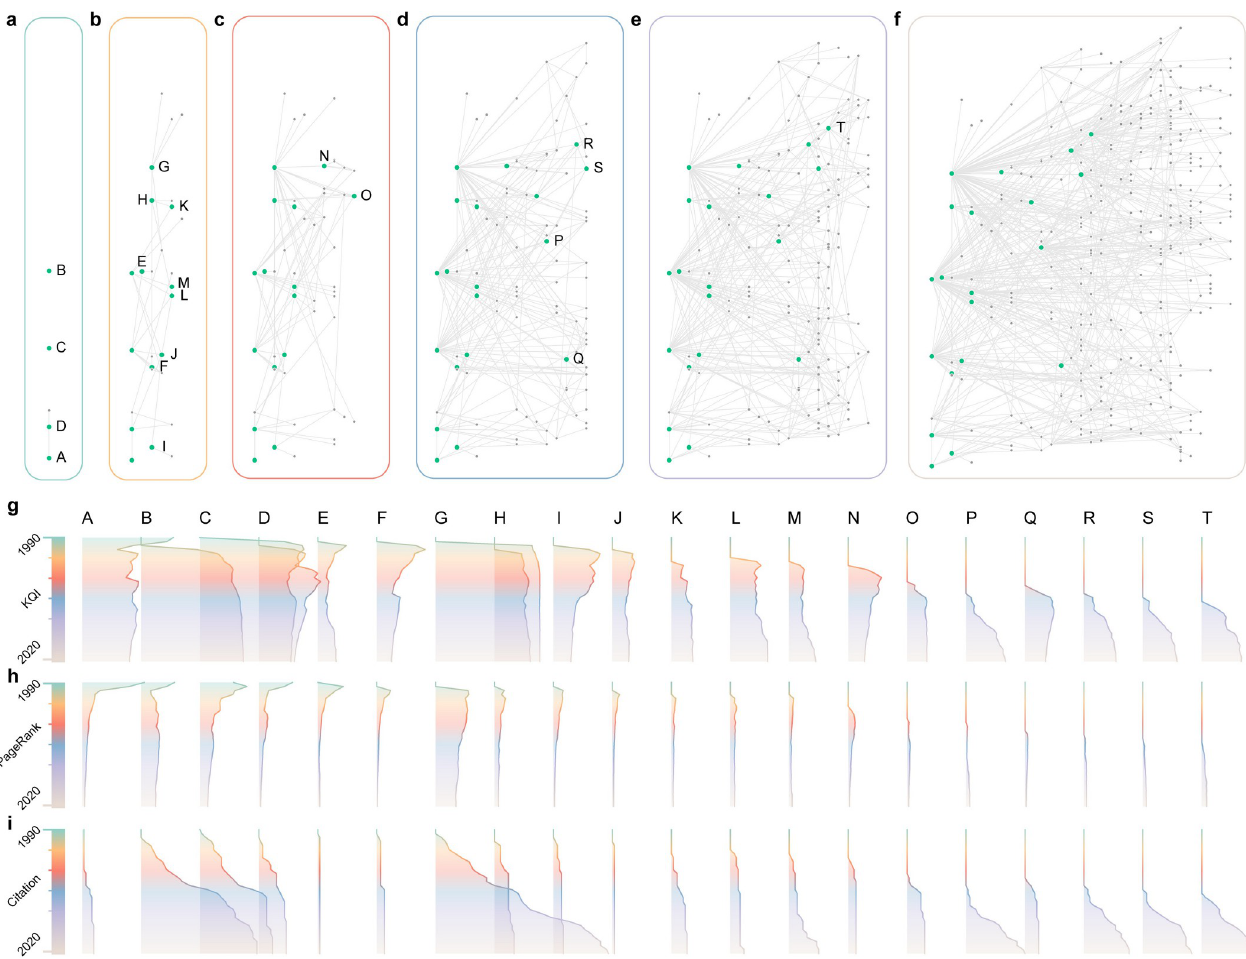
Fig 5. KQI changes with the evolutional network. a-f, Simplified evolutional network on informetrics field from 1990 to 2021. Nodes represent the articles and edges represent the citation relationships. The nodes at the right cite the nodes at the left, in chronological order from left to right. The networks correspond to snapshots in 1990, 1995, 2000, 2005, 2010, and 2020 respectively. Additional 20 nodes (green) are marked to specifically compare with changes in metrics. g-i, KQI, PageRank, and citation variation of typical nodes. The gradient color corresponds to the evolution time of a-f . F, I, N, Q represent articles that gradually drifted away from the research center, with reduced KQI, reduced PageRank, and smooth citations. E, J represent articles that are little-known but enlightening, with considerable KQI and few citations. A, C, D shows that PageRank of articles whose citations do not continue to grow decreases, while the KQI stays high. B, G shows that increasing citations maintain PageRank. D, E, M shows that KQI reflects the change of research hotspots in the